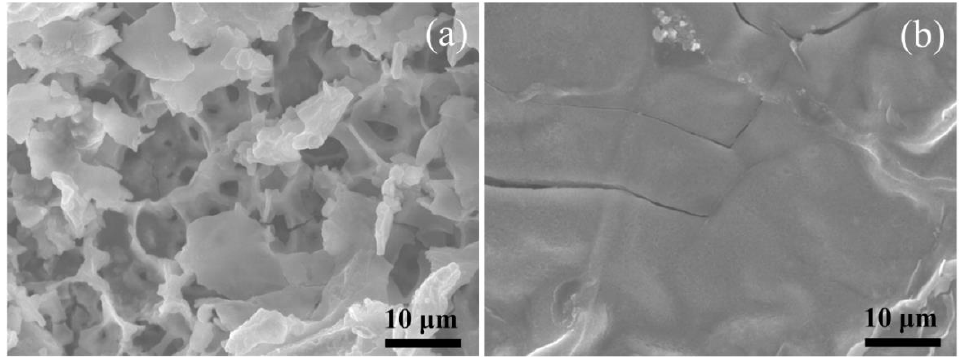
Figure 7. SEM images of the electrode based on ( a ) MS and ( b ) MS/CN after 200 cycles at 0.05 C for the first cycle and 1 C for the next cycles.